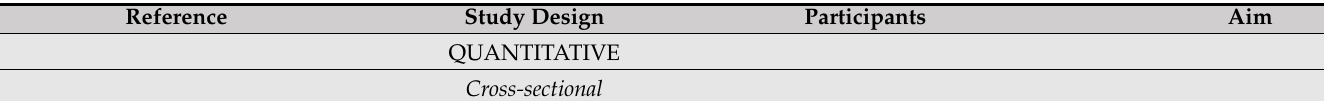
Table 2. Articles in the second category: one